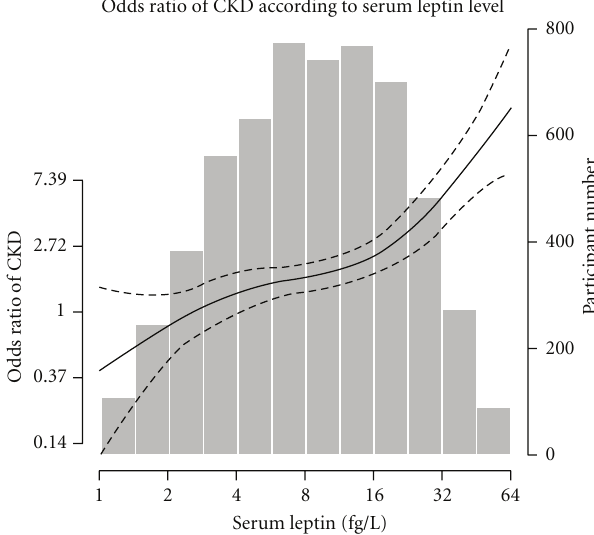
Figure 1: Multivariable-adjusted odds ratio of chronic kidney disease (CKD) according to plasma leptin level (Fg/L). Solid thick line represents the predicted odds of CKD from nonparametric logistic regression; dashed lines, 95% confidence limits for the nonparametric logistic regression estimates. The nonparametric logistic regression was adjusted for age (years), sex (men, women), race-ethnicity (non-Hispanic whites, non-Hispanic blacks, Mexican Americans, others), education categories ( < high school, high school, > high school), smoking (never, former, current), body mass index (normal, overweight, obese), diabetes (absent, present), and serum total cholesterol (mg/dL). The median value of quartile 1 of leptin (1.285Fg/L) was used as the referent category to calculate odds ratios. X axis: plasma leptin level (fg/L) plotted in log scale, Y 1 axis: predicted odds ratio of CKD plotted in log scale, Y 2 axis: participant number for each serum plasma leptin